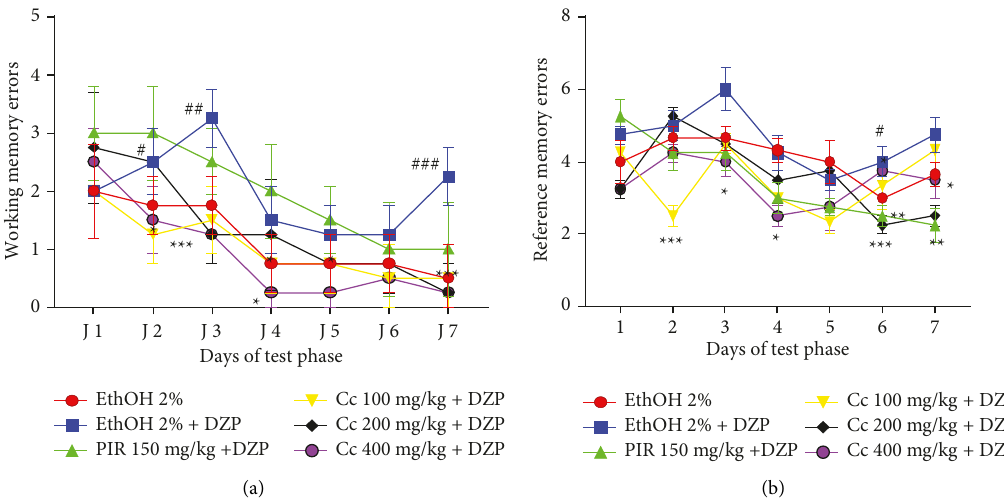
Figure 1: Effect of ethanolic extract of Cc on the working (a) and reference (b) memory errors of mice in the radial maze test. Each point represents the mean ESM, n 5. DZP diazepam, PIR piracetam, Cc ethanolic extract of Crassocephalum crepidioides (cid:31) (cid:31) (cid:31) (cid:31) ± curve was constructed using MDA as standard and the results were expressed as μ mol/g of the organ.